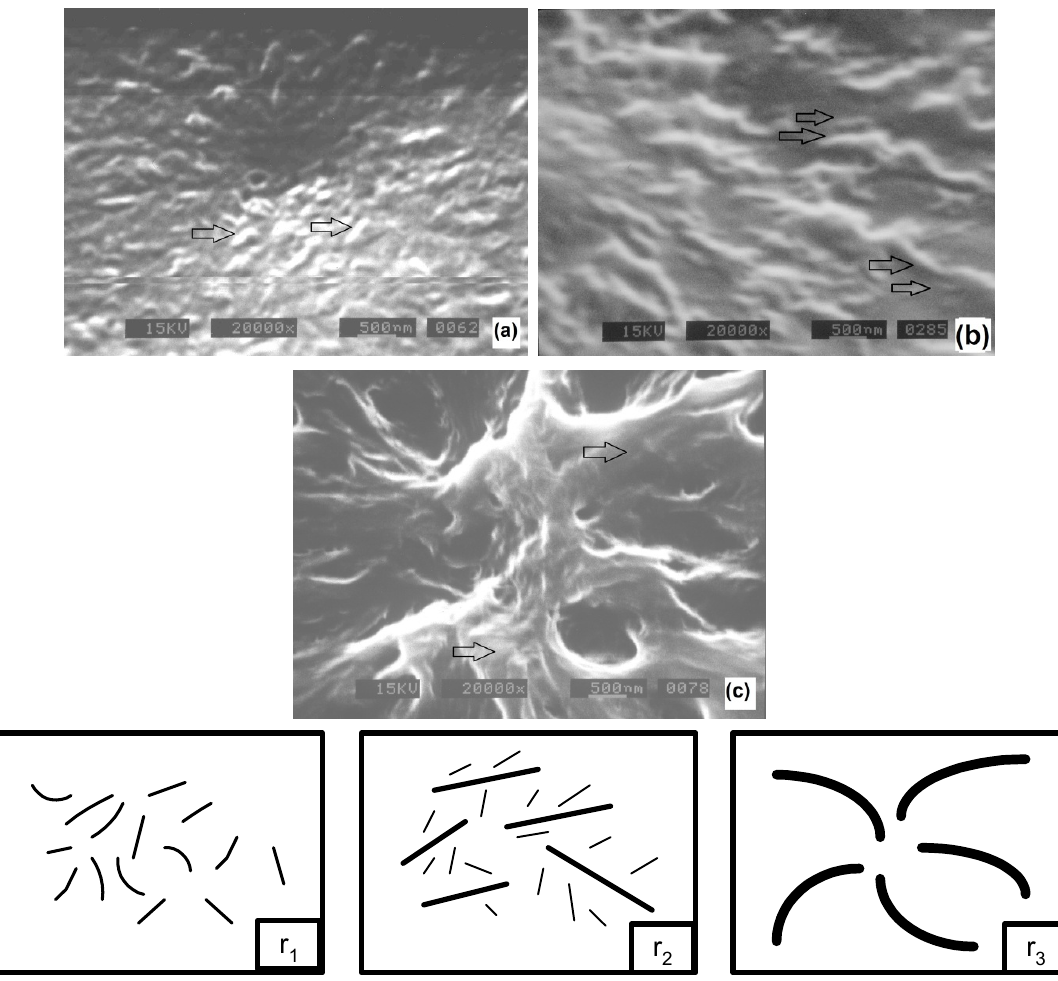
Figure 6. SEM micrographs of isothermally crystallized (30 min) PET-HMw at different temperatures: ( a ) 140 °C; ( b ) 200 °C; and ( c ) 220